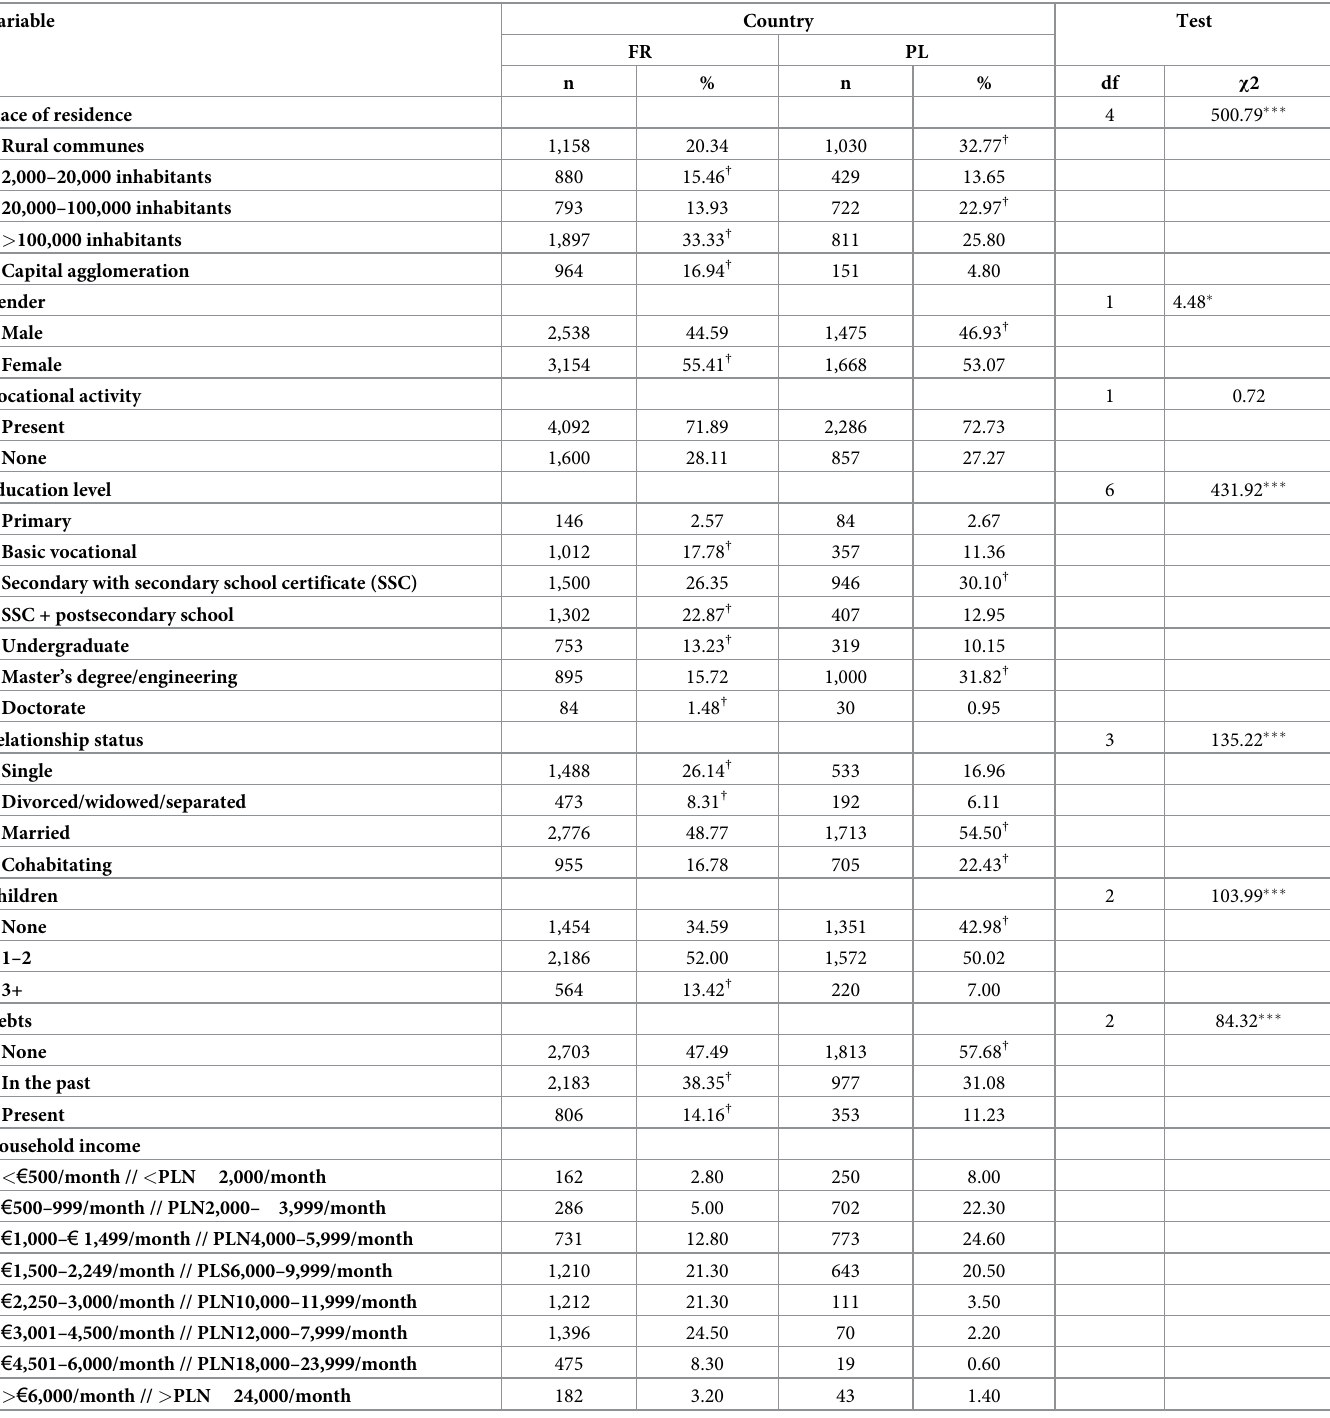
Table 1. Sociodemographic characteristics of French ( n = 5,692) and Polish ( n = 3,143) sample.